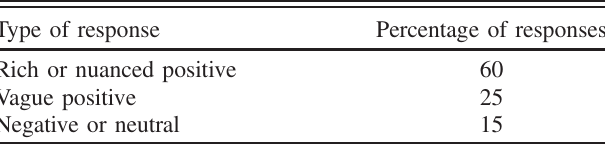
TABLE II. Responses to an open-ended prompt asking students to “ say a little bit about how the use of the life-science examples did or did not spark your interest ” were coded and categorized into one of three groups. Qualitative responses from four iterations of the IPLS course (years 1 – 4, N ¼ 175 responses) were analyzed, and the percentage of responses belonging to each group is